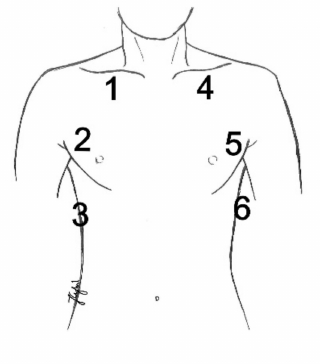
Figure 1. Lung ultrasound assessment points in the